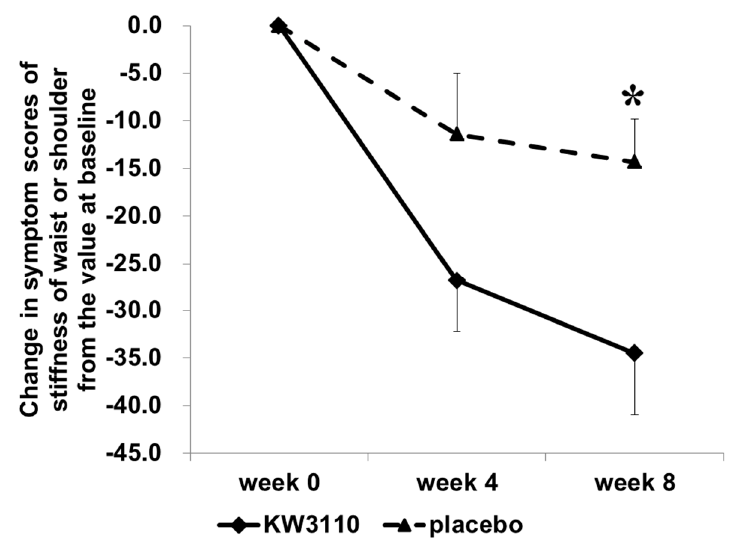
Figure 4. Changes in symptom scores of stiffness of the waist or shoulders from the values during week 0 in subjects with severe ocular fatigue sensation before the VDT load. VDT = visual display terminal. Data are calculated as the degrees of change from the values during week 0. The comparisons between two groups at each time point were performed by an unpaired Student’s t -test with a Holm correction for multiple comparisons (* p < 0.05 versus placebo). Data are shown as the means ± SE. KW3110 = L. paracasei KW3110-treated group, placebo = control group.